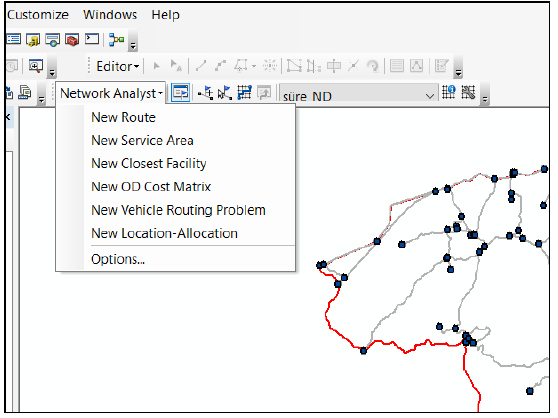
Figure 2. The methods under Network Analyst